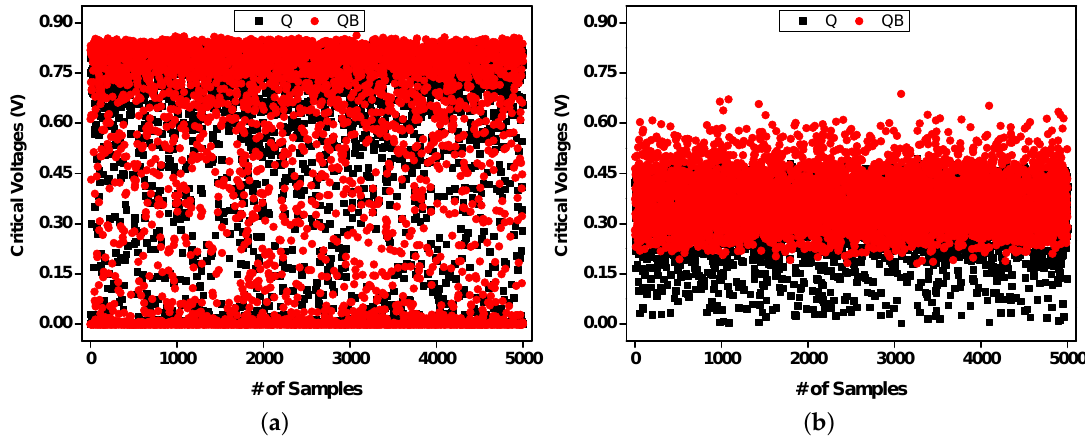
Figure 11. Distribution of critical voltages ( V crit ) with 5000 Monte Carlo samples for V Q and V QB for ( a ) 6T SRAM cell ( b ) AS10T SRAM cell. The distribution indicates the repeatibility of the critical voltage for 6T and AS10T SRAM